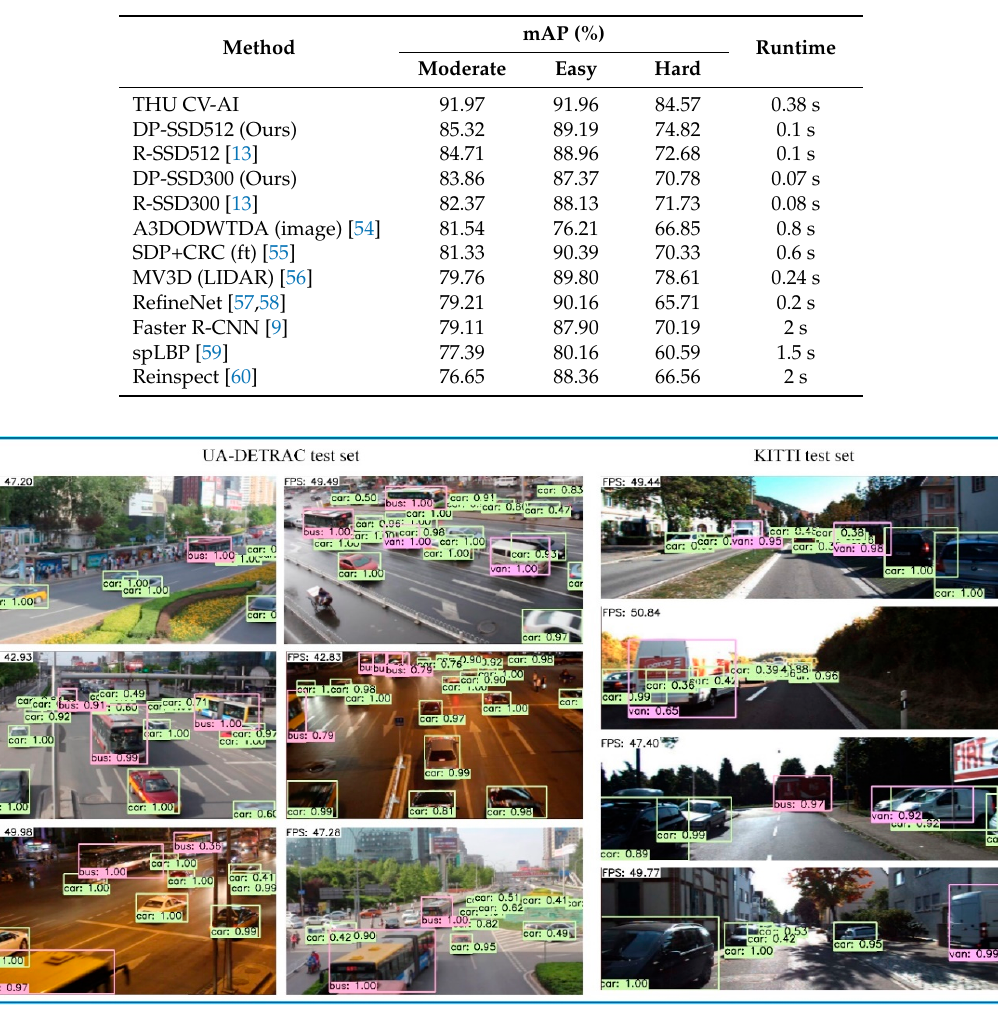
Table 7. Detection results between different methods on KITTI test set. All methods are ranked based on the “Moderate”.